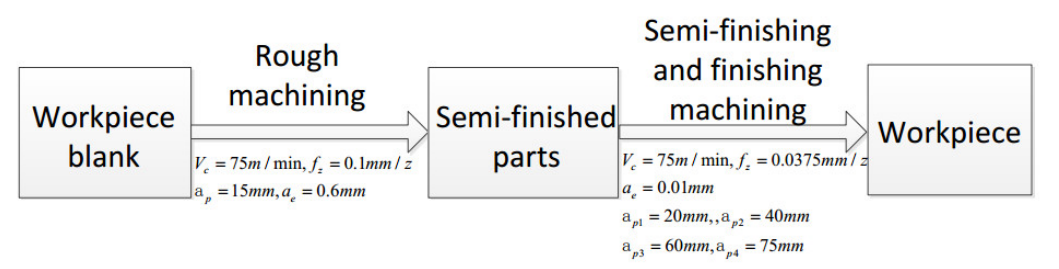
Figure 2. The process flow chart.